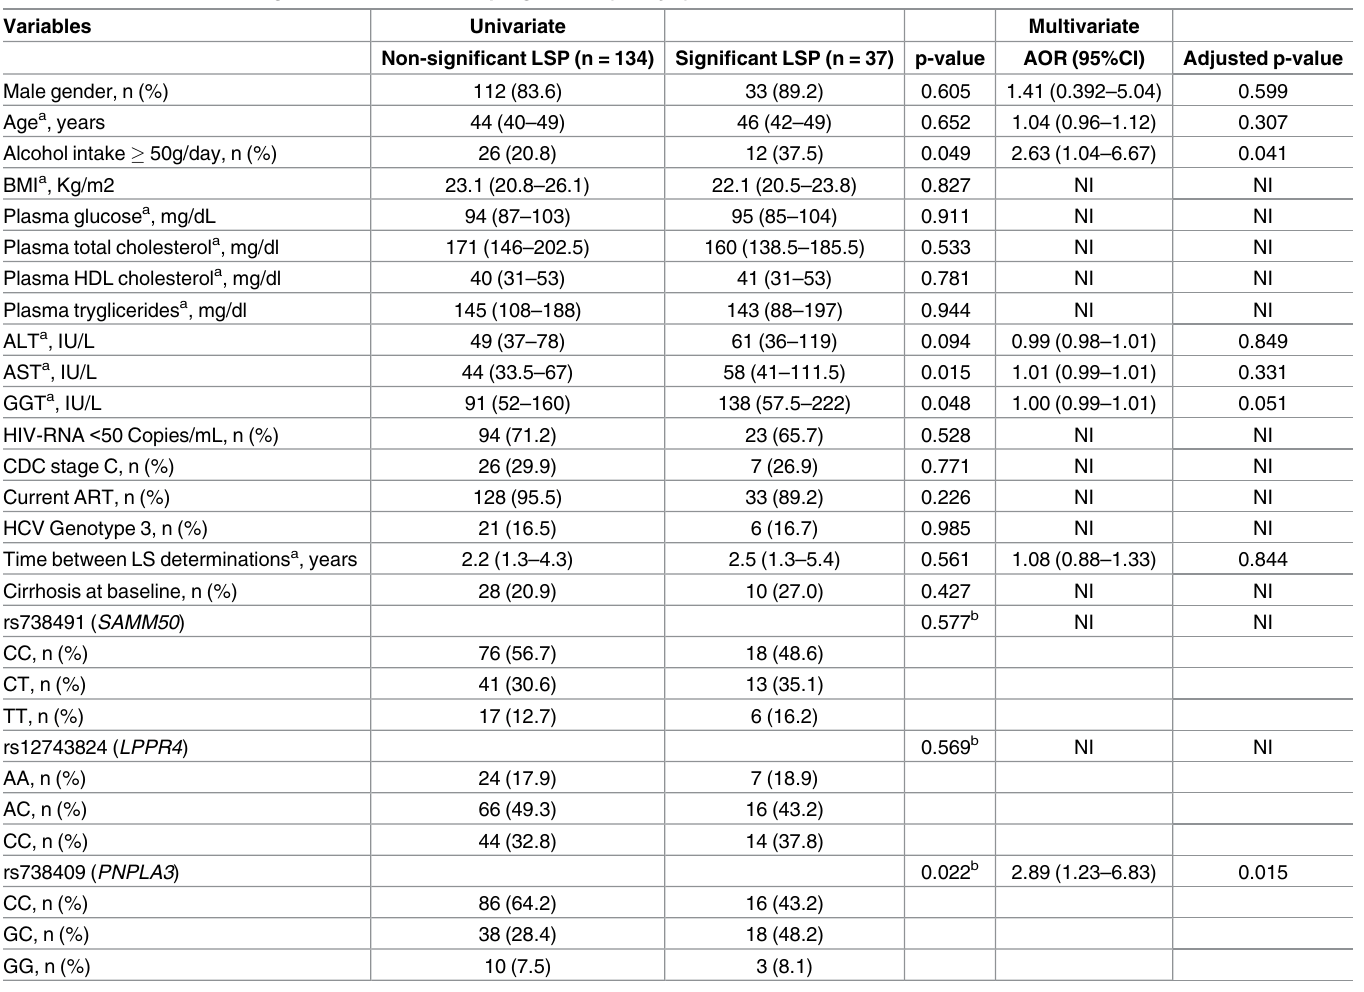
Table 3. Associations with significant liver stiffness progression (Study 2).